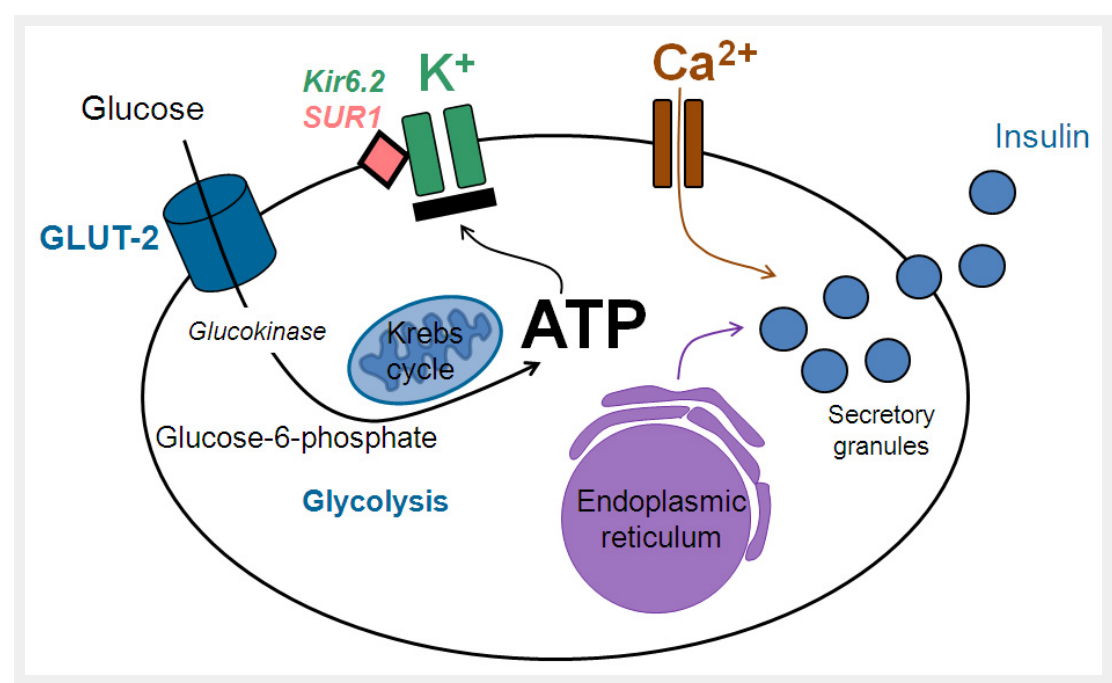
Pancreatic beta cell: the coupling of glucose sensing via GLUT-2 transporters, generation of ATP, membrane depolarization by closing potassium channels, entering of calcium ions, and exocytosis of insulin.